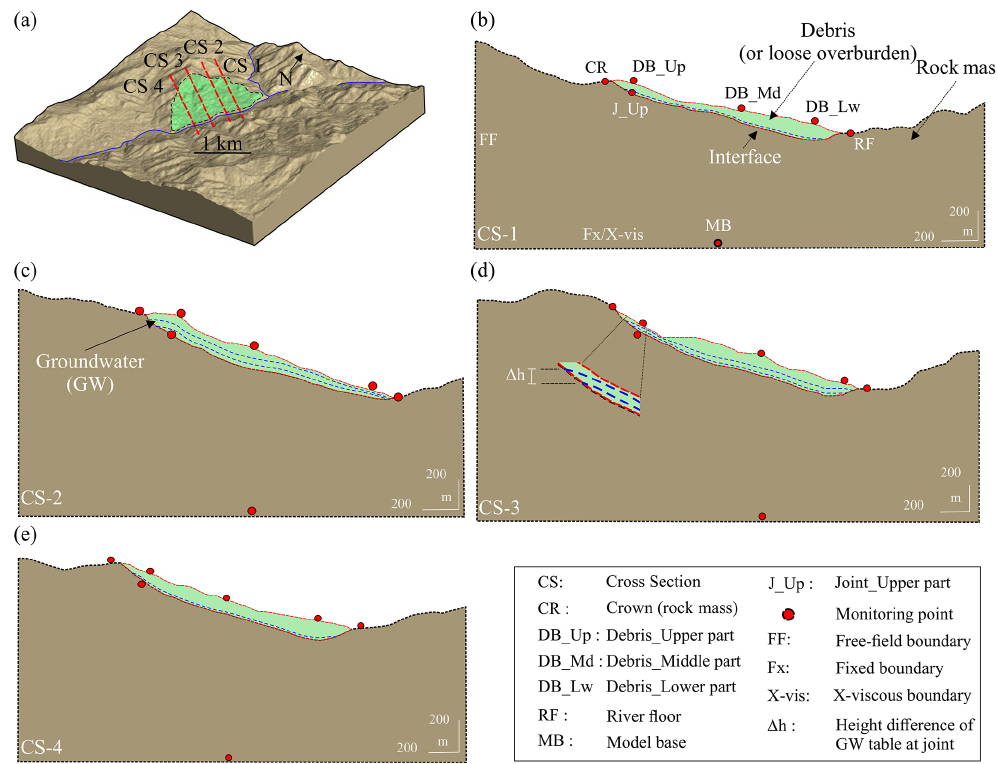
Figure 6. Model configuration for the slope stability analysis. (a) Landslide model. The location of the different cross sections used in the UDEC models are marked by red lines. (b–e) Configuration of the sections: CS-1 to